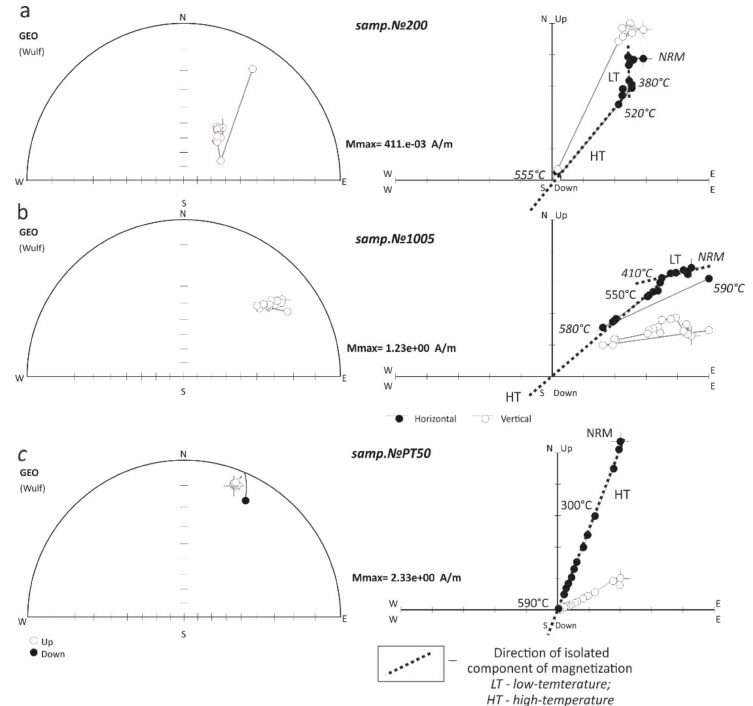
Figure 4. Representative orthogonal demagnetization diagrams and equal-area stereonet plots of mafic bodies of the Udzha Uplift. ( a ) Sample No. 200—the Great Udzha Dyke (1); ( b ) sample No. 1005—sill at the Udzha and Hapchanyr river junction (2); ( c ) sample No. PT50—dyke